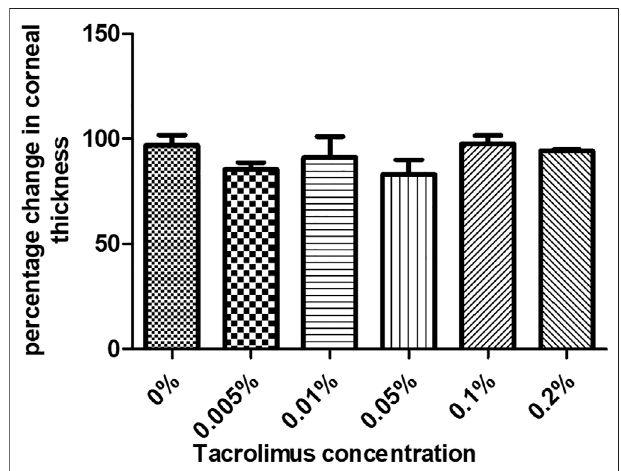
FIGURE 1 | The effect of tacrolimus treatment on corneal thickness. Percentage change in corneal thickness from pretreatment measurements is represented by bars. Each bar shows the average from three corneas ( n = 3). Error bars represent standard